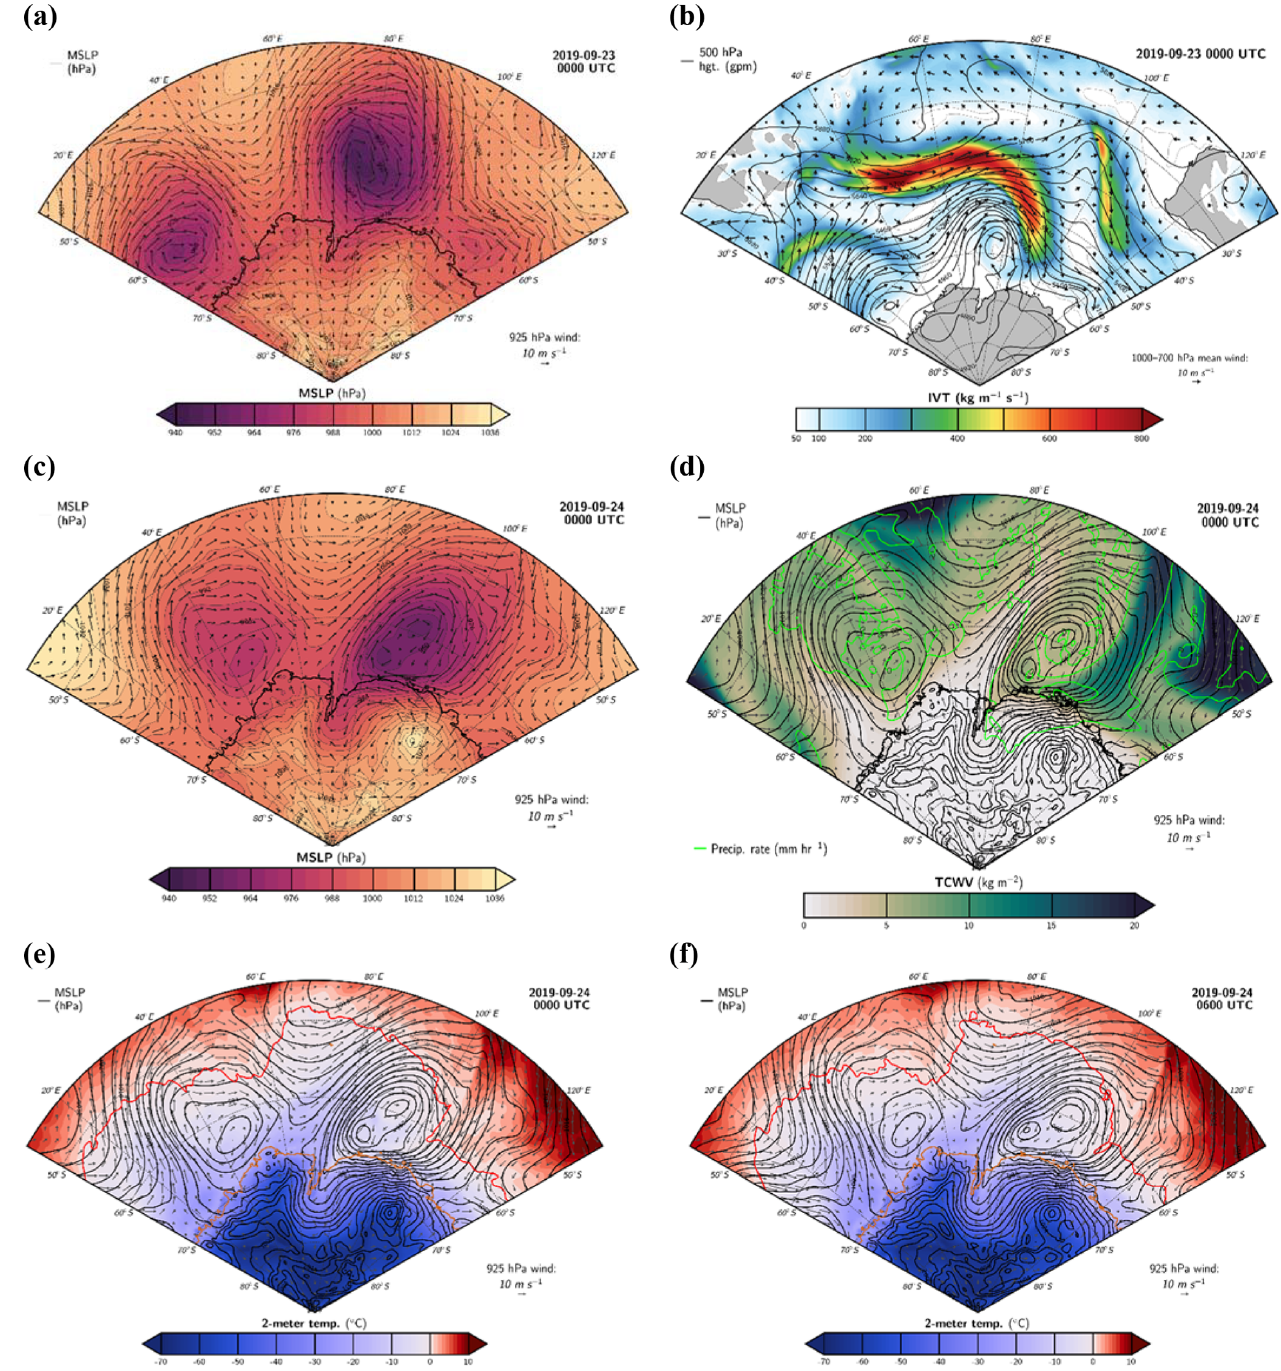
Figure 5. (a) MSLP in colors and winds at 925hPa in vectors on 23 September 2019 at 00:00UTC; (b) integrated water vapor transport (IVT) in colors, with geopotential heights (hgt. (gpm)) at 500hPa in black contours and 1000–700hPa mean winds in black vectors on 23 September 2019 at 00:00UTC; (c) MSLP in colors and winds at 925hPa in vectors on 24 September 2019 at 00:00UTC; (d) total column water vapor (TCWV) in colors, with winds at 925hPa in vectors, precipitation (precip.) rate in green contours and MSLP in black contours on 24 September 2019 at 00:00UTC; (e) 2m temperature in colors, with winds at 925hPa in vectors, MSLP in black contours and 0 ◦ C contour in red on 24 September at 00:00UTC; (f) same as (e) but at 06:00UTC. Please note that the date format used in this figure is year month day